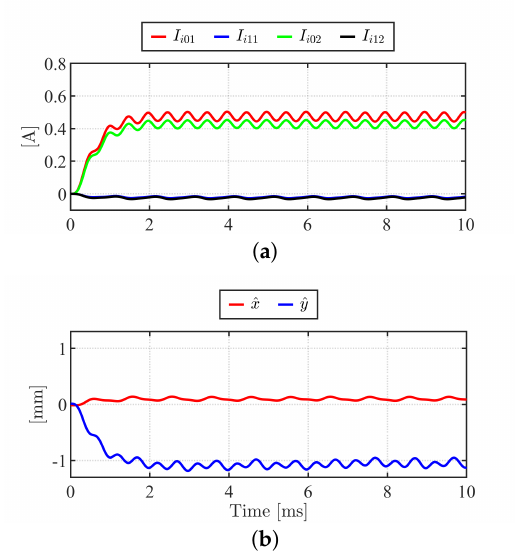
Figure 13. xy -position estimation experimental results, x = 0 mm, y = − 1 mm. ( a ) demodulated α and β HF current, I i 01 , I i 11 , I i 02 , and I i 12 ; ( b ) estimated xy -position, ˆ x and ˆ y .